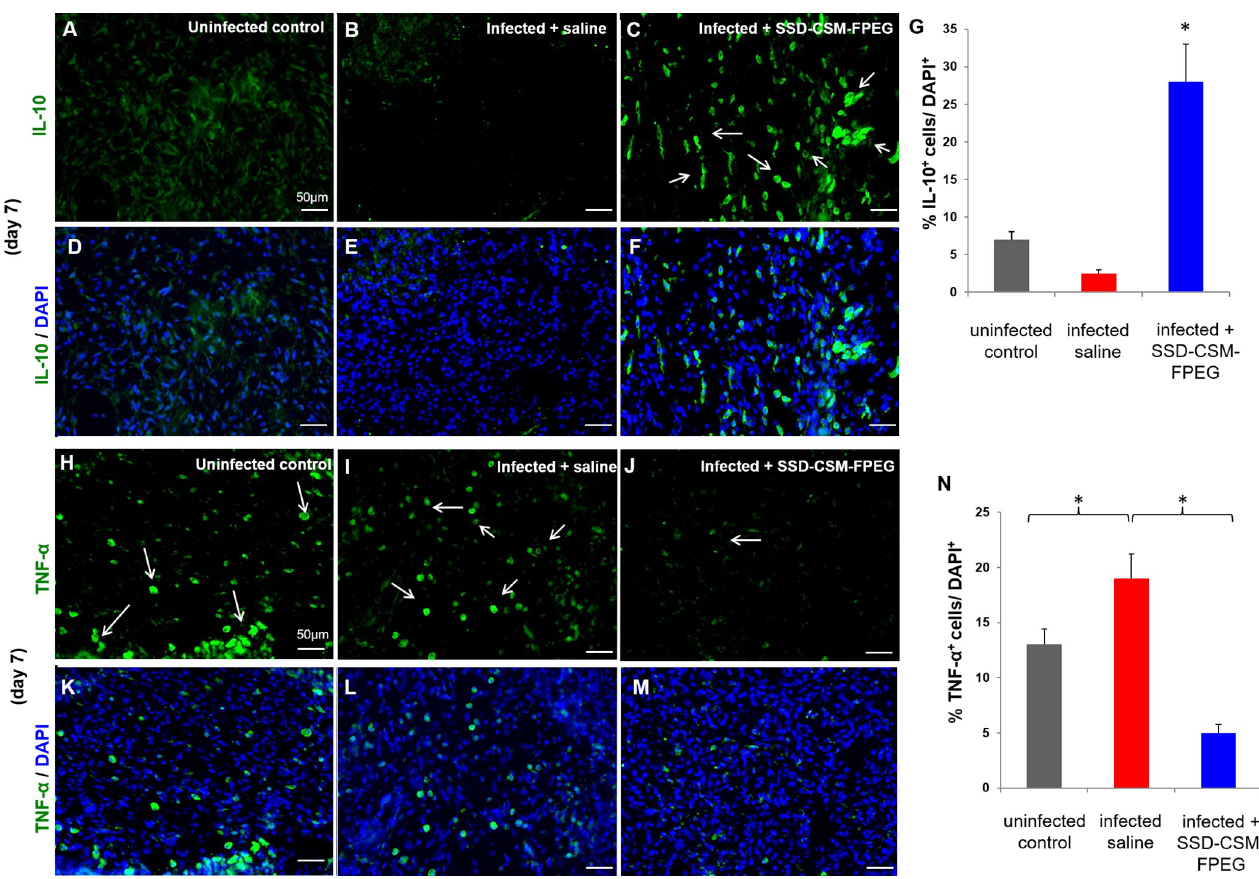
Fig 3. SSD-CSM-FPEG reduces inflammation. (A-G) SSD-CSM-FPEG exhibits increased anti-inflammatory marker IL-10. Day 7 wound tissue exhibits increased expression of IL-10 (green, white arrows) in wound tissue treated with SSD-CSM-FPEG as compared to infected saline treated samples. ( n = 4, p < 0.05). (H-N) SSD-CSM-FPEG exhibits decreased pro-inflammatory marker TNF- α . Day 7 wound tissue exhibits decreased expression of TNF- α (green, white arrows) in wound tissue treated with SSD-CSM-FPEG as compared to infected saline treated samples. ( n = 4, p <